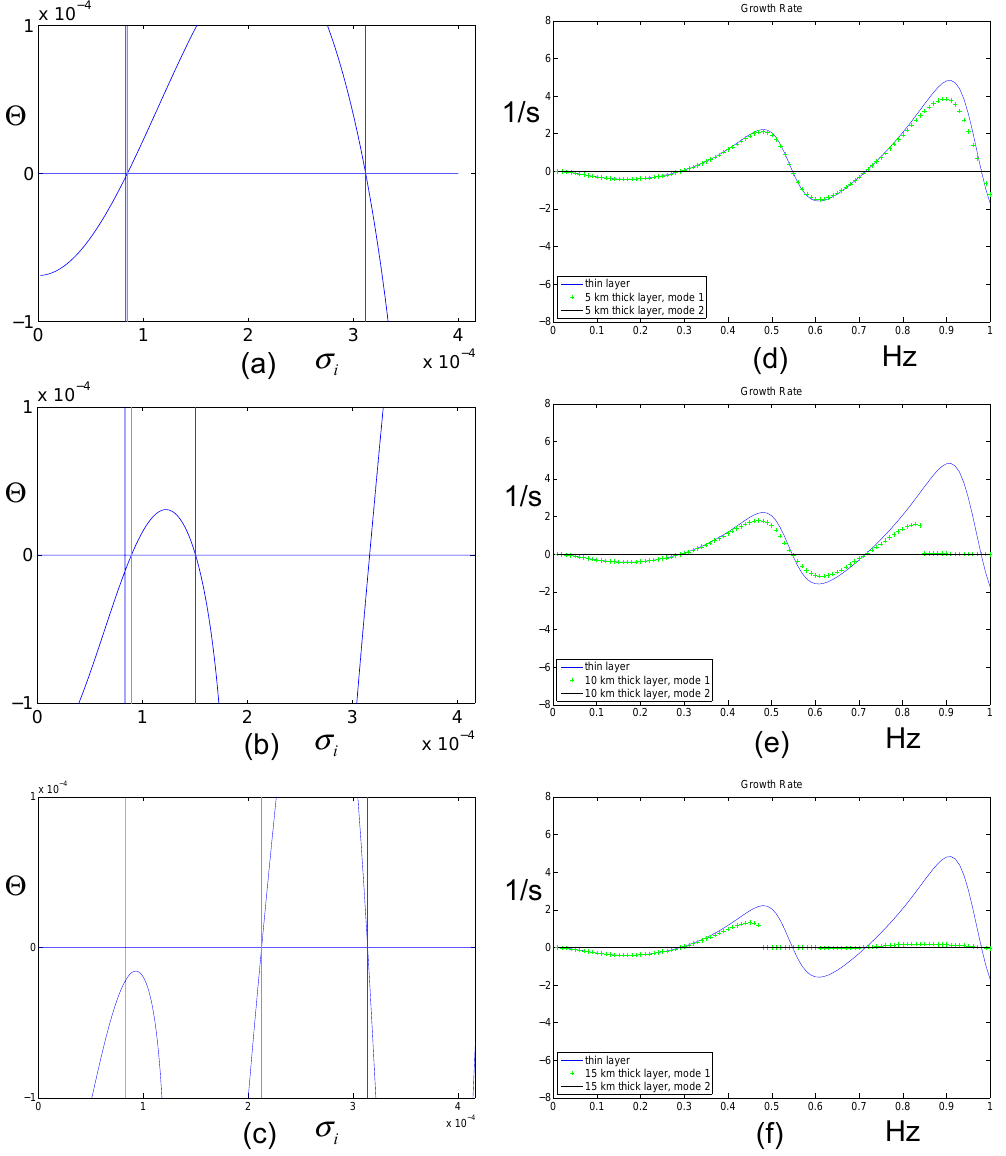
Fig. 4. Panels (a) through (c) show the function 2(σ i ) plotted versus σ i , for three different layer thicknesses all having the same integrated conductivity: (a) 5km thick layer, (b) 10km thick layer, and (c) 15km thick layer. The vertical blue line marks σ i for the thin-layer solution. The vertical green (red) line marks σ i for the actual solution with the largest (second largest) growth rate. This shows the cutoff of the fundamental (thin-layer) mode when the layer becomes too thick. Panels (d) through (f) show the growth rate plotted versus frequency for the same three layer thicknesses: (d) 5km thick, (e) 10km thick, and (f) 15km thick. These show the convergence of the growth rate to the thin layer value. For all, the background electric field is 50mVm − 1 ; the altitude is 120km; and the field line integrated Pedersen and Hall conductivities are 1.14mhos and 4.53mhos,